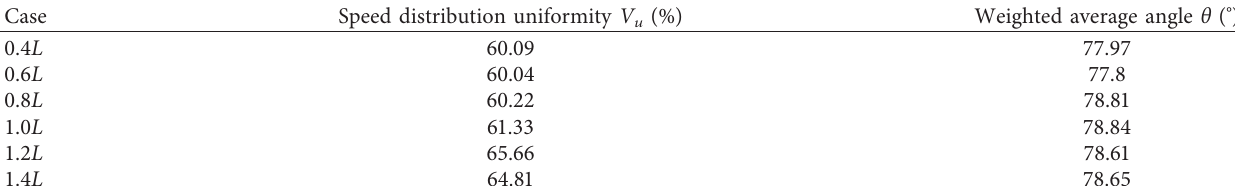
Table 3: The uniformity of velocity distribution V u and the weighted average angle θ vary with the length of the inlet duct.